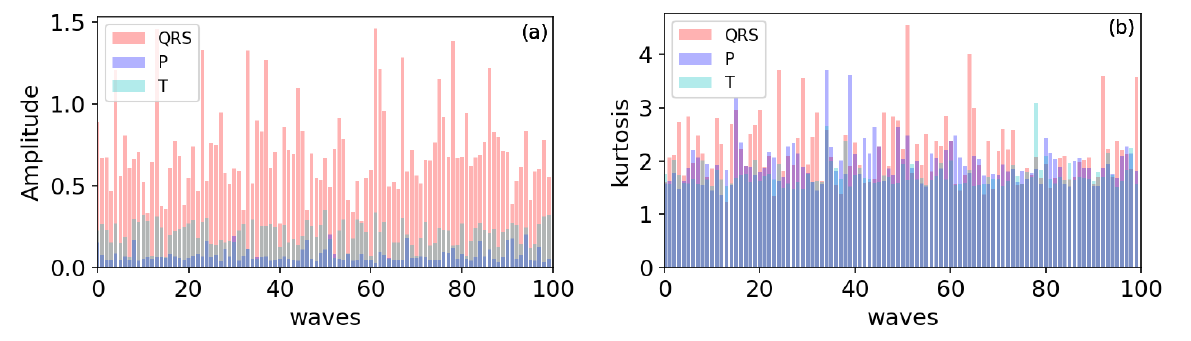
Figure 7. The comparison of QRS complexs distributions with P/T waves. All waves were extracted from the qtdb dataset: ( a ) amplitude; ( b )